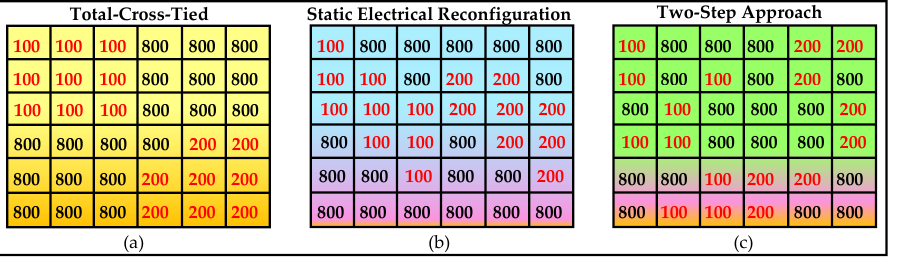
Figure 14. Irradiance received by the 6 × 6 PV array during partial shading S5 for ( a ) conventional, hybrid and TCT, ( b ) static electrical reconfiguration (shade dispersion), and ( c ) the two-step ap- proach (shade dispersion).